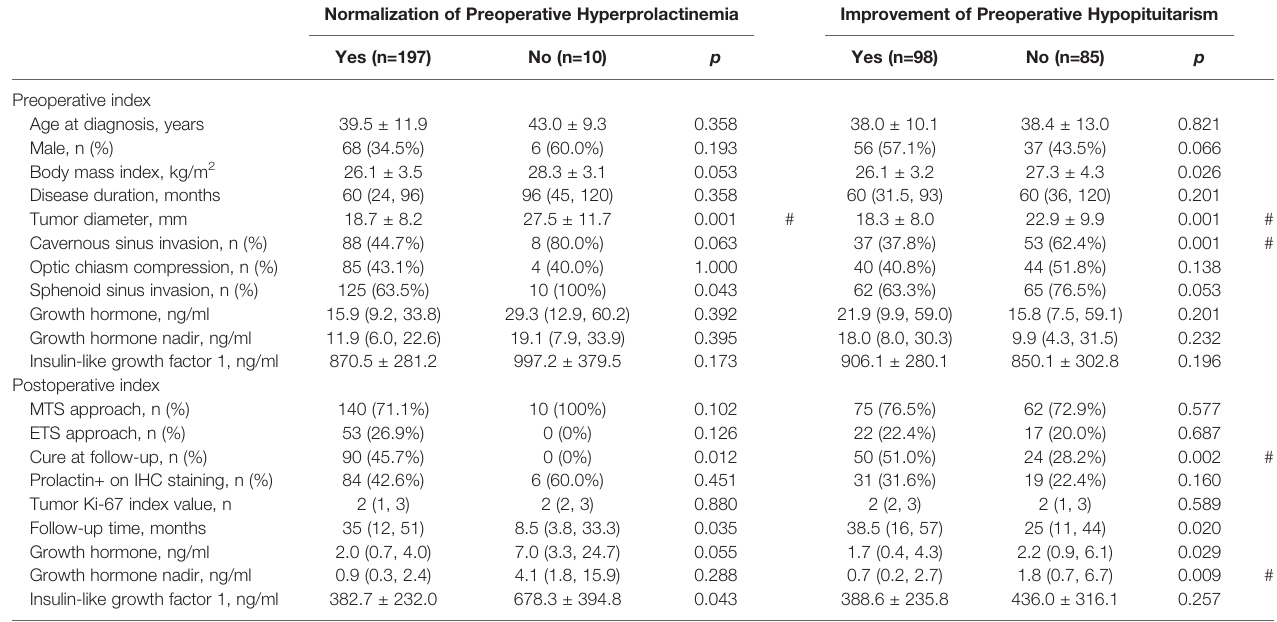
TABLE 3 | Predictors of prolactin normalization and hypopituitarism improvement after surgery. Normalization of Preoperative